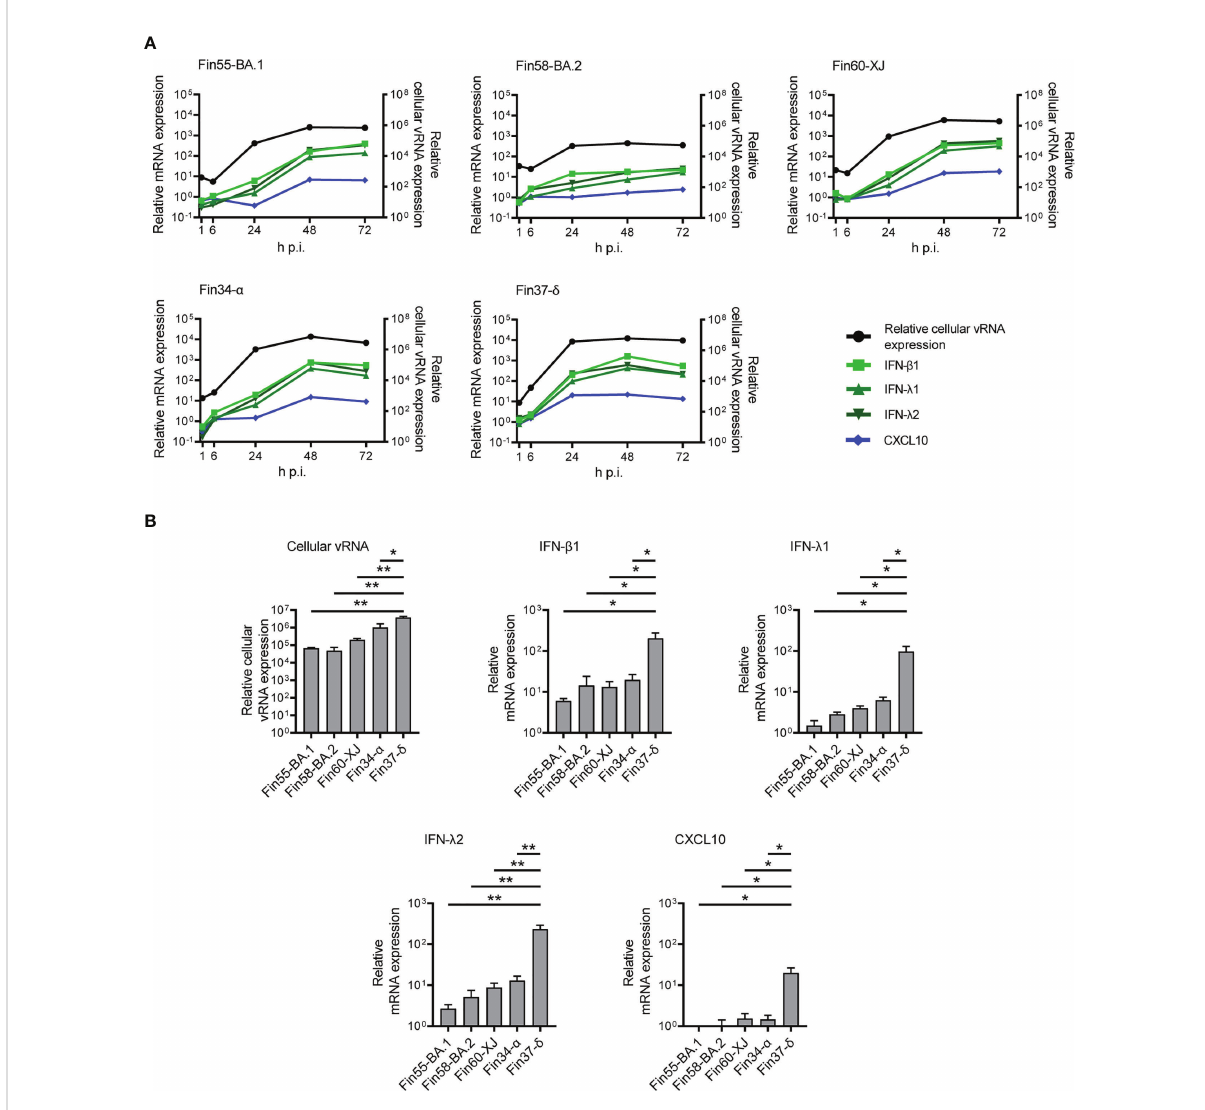
FIGURE 8 Interferon and CXCL10 mRNA expression levels in Calu-3 cells with Omicron infection. The Omicron sublineages BA.1, BA.2 and recombinant XJ as well as the Alpha and Delta variants were used for infecting Calu-3 cells at a MOI of 1 TCID 50 /cell, and total RNA samples were collected at different time points for RT-qPCR analysis. (A) IFN- b 1, IFN- l 1, IFN- l 2 and CXCL10 mRNA expression pro fi les determined by RT-qPCR (left Y axis) compared to the relative cellular vRNA expression pro fi le (right Y axis) for cells infected with three Omicron variants (Fin55-BA.1, Fin58- BA.2 and Fin60-XJ), and with Alpha (Fin34- a ) and Delta (Fin37- d ). The means of three independent experiments are shown. (B) Comparison of relative cellular vRNA and IFN- b 1, IFN- l 1, IFN- l 2 and CXCL10 mRNA expression at 24 h p.i. The results are the mean values ± SEM of three independent experiments. One-way ANOVA with Tukey ’ s multiple comparisons test was used for the statistics. P < 0.05 (*), P < 0.01